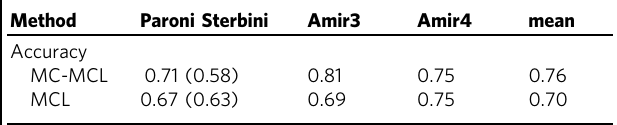
Best results of clustering (highest accuracies, regardless of the normalization and type of correlation) MCL and MC-MCL, in each of the three studied datasets (Paroni Sterbini, Amir3 and Amir4), and the mean performance (mean of the highest accuracies) across all the datasets. For Paroni Sterbini dataset, we show the results for three clusters (PPI treated, untreated H + and untreated H − ) and in brackets the results for four clusters (P&H + , P&H − , untreated H + and untreated H − ). Instead, for Amir datasets, the accuracies were computed for two groups, identi fi ed according to the presence or absence of PPI treatment. All accuracies can be found in